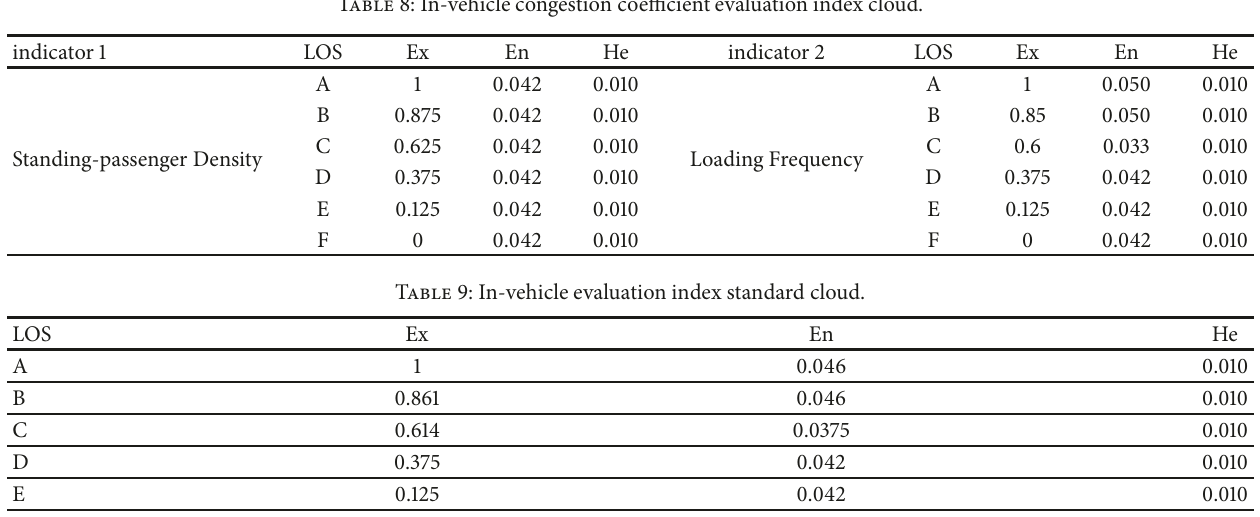
Table 8: In-vehicle congestion coefficient evaluation index cloud.